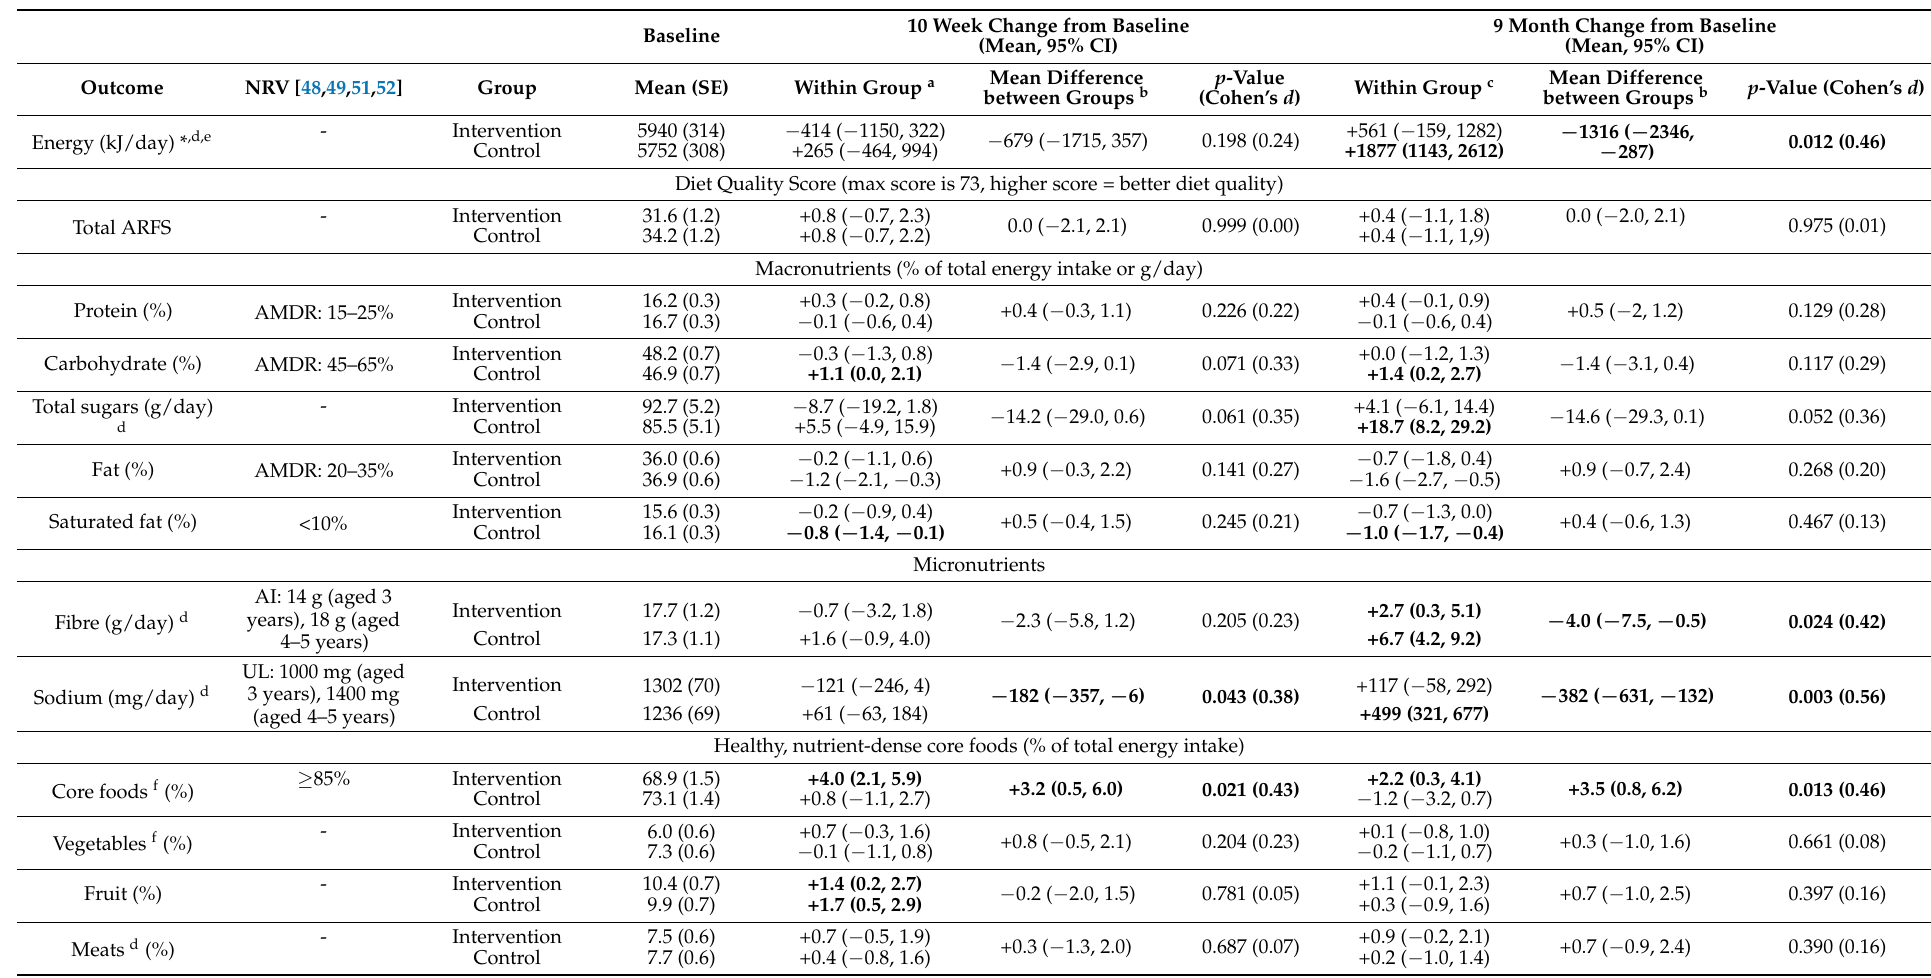
Table 2. Change in dietary intake of children enrolled in the Healthy Youngsters, Healthy Dads (HYHD) RCT (intention to treat). Baseline 10 Week Change from Baseline (Mean, 95% CI) 9 Month Change from Baseline (Mean, 95%